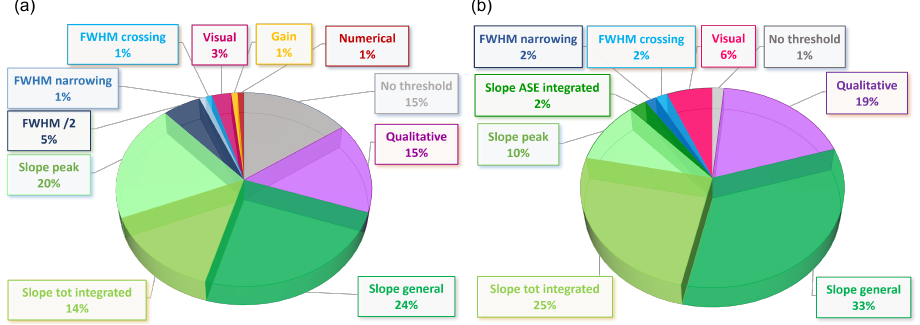
Figure 1. Pie charts showing the percentage distribution of the methods used to define the ASE threshold in ( a ) dye-polymer blends and ( b ) perovskites.